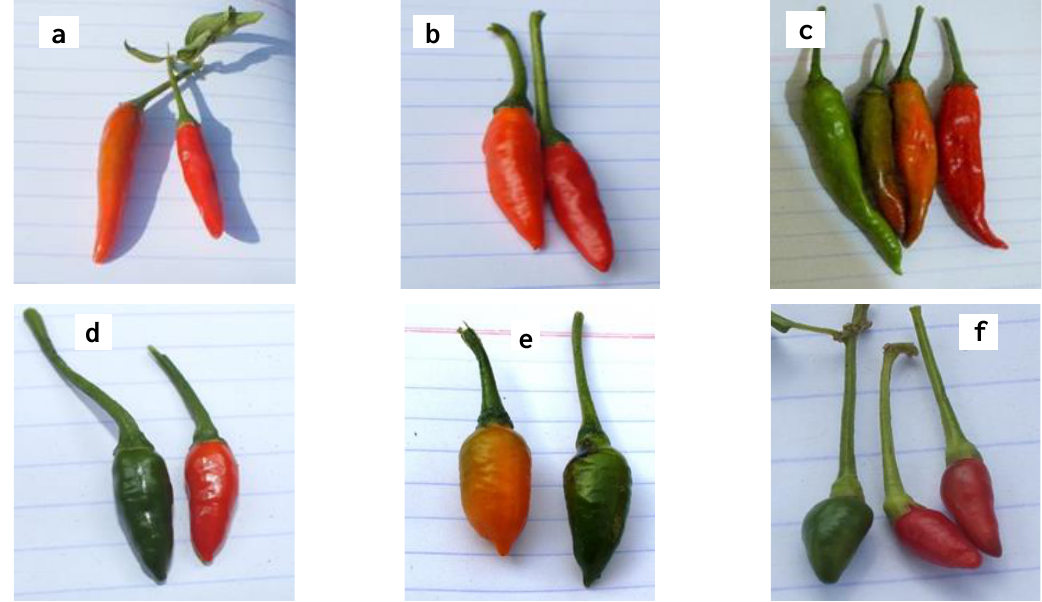
Figure 2. Fruit from selected Capsicum pepper genotypes evaluated. UG2-WE0106-01 (a), UG2-WE0103-05 (b), UG2-NO0211-09 (c), UG2-WE0502-20 (d), UG2- WE0511-22 (e) and UG-EA06-0515